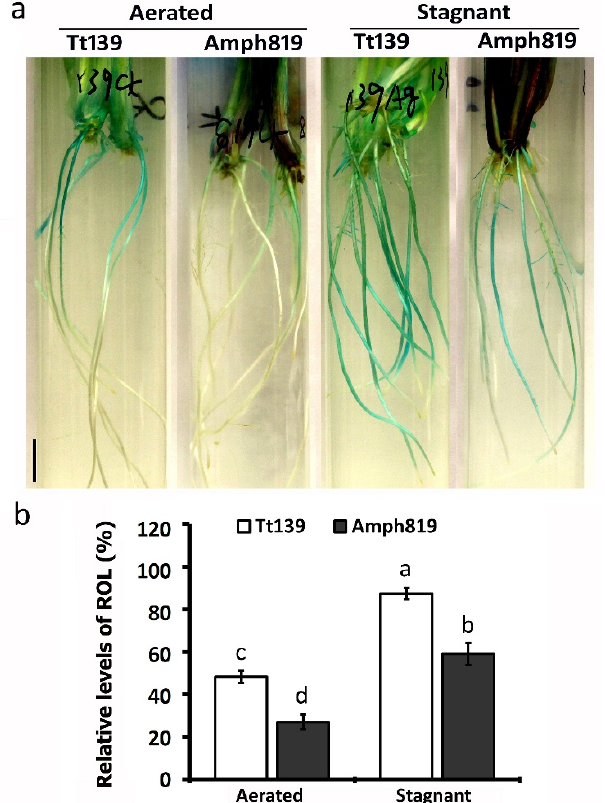
Figure 3. Patterns of ROL along with secondary roots of Tt139 and Amph819 under aerated and stagnant conditions. ( a ) ROL from secondary roots visualized by methylene blue staining in an oxygen-free medium. The seedlings were grown under aerated and stagnant conditions for 2 weeks. The blue color indicates oxygen that has diffused outward from roots. Bars = 1 cm. ( b ) Relative level of ROL. These data are based on the ratio of methylene blue staining (blue staining length/root length). Values are means ± SE ( n = 16) from more than 6 plants in each treatment. Letters indicate significant differences between means, determined using Duncan’s multiple range test (5% α ).